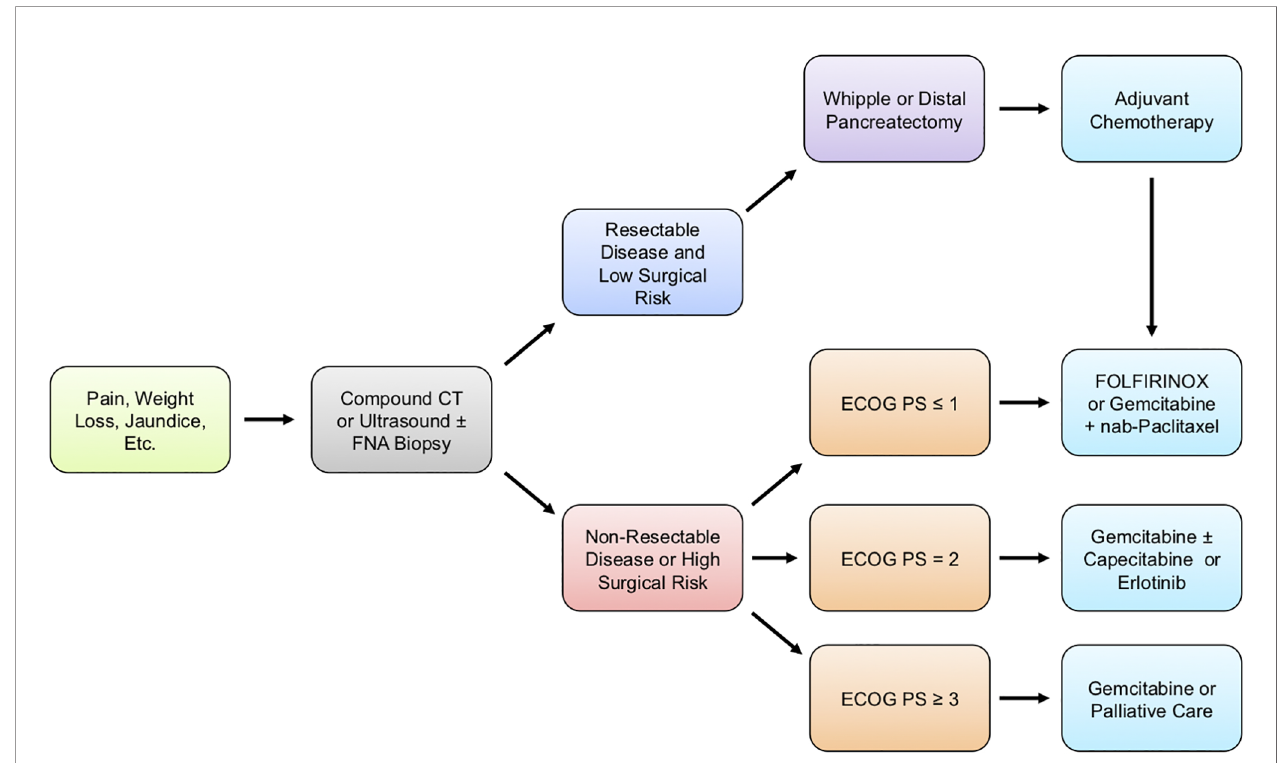
FIGURE 1 | Generalized treatment guidelines for PDAC patients. Pancreatic ductal adenocarcinoma (PDAC) typically presents with vague clinical symptoms, including poorly localized pain, jaundice, or unintended weight loss. When PDAC is suspected, patients are typically diagnosed through computed tomography (CT) scan of the chest, abdomen, and pelvis to assess the extent of disease or ultrasound with or without a fi ne-needle aspiration (FNA) biopsy. Following con fi rmatory diagnosis, the patient ’ s surgical candidacy is determined based on a combination of imaging studies, Eastern Cooperative Oncology Group performance status (ECOG PS), symptom burden, surgical risk, and comorbidity pro fi le. For operable disease, the type of surgery is determined based on the anatomical location of the tumor, as well as several additional factors described in this review article, with most patients receiving either a Whipple procedure or distal pancreatectomy. Regardless of whether a patient is treated with surgery, the current guidelines recommend chemotherapy, and the precise regimen given is based mostly on ECOG PS and comorbidity pro fi